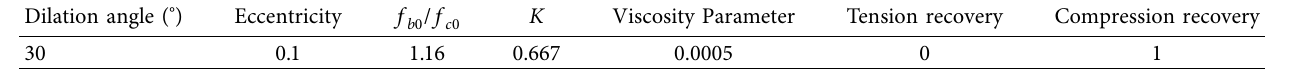
Table 2: Parameters (plasticity and stiffness recovery) of concrete in the CDP